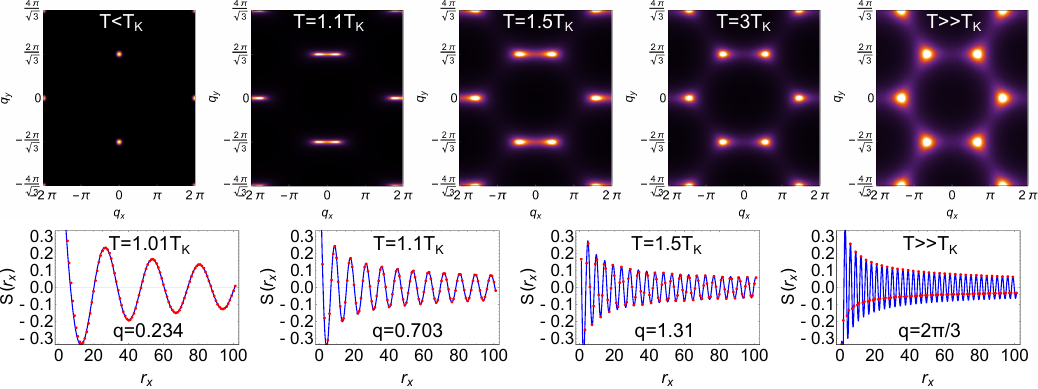
[ Eq. 32 ] . (Top) The reciprocal-space structure factor S ( q ) Figure 18: The structure factor of H ABB at various temperatures, calculated by Monte Carlo simulation for a hexagonal cluster with L = 72. (cid:112) For T < T K there are Bragg peaks at q stripe = ( 0,2 π/ 3 ) , and these have been artificially broadened (cid:112) for clarity. For T > T K there are divergencies at the wavevectors q string ( T ) = ( ± π n string ,2 π/ 3 ) that go as S ( q string + δ q ) ∝ | δ q | − 3 / 2 . For T (cid:29) T K the physics of the isotropic TLIAF is recovered, with (cid:112) n string = 2 / 3 and q string ( T ) = ( ± 2 π/ 3,2 π/ 3 ) . (Bottom) The real-space structure factor, S ( r x ) [ Eq. 4 ] , in the direction perpendicular to the strings (i.e. parallel to A bonds), calculated in the thermodynamic limit using the Grassmann path integral approach (see Appendix F). Red dots show calculations and (cid:112) r x , where A is the only free parameter. the blue line shows the best fit to S ( r x ) = A cos ( π n string r x ) /